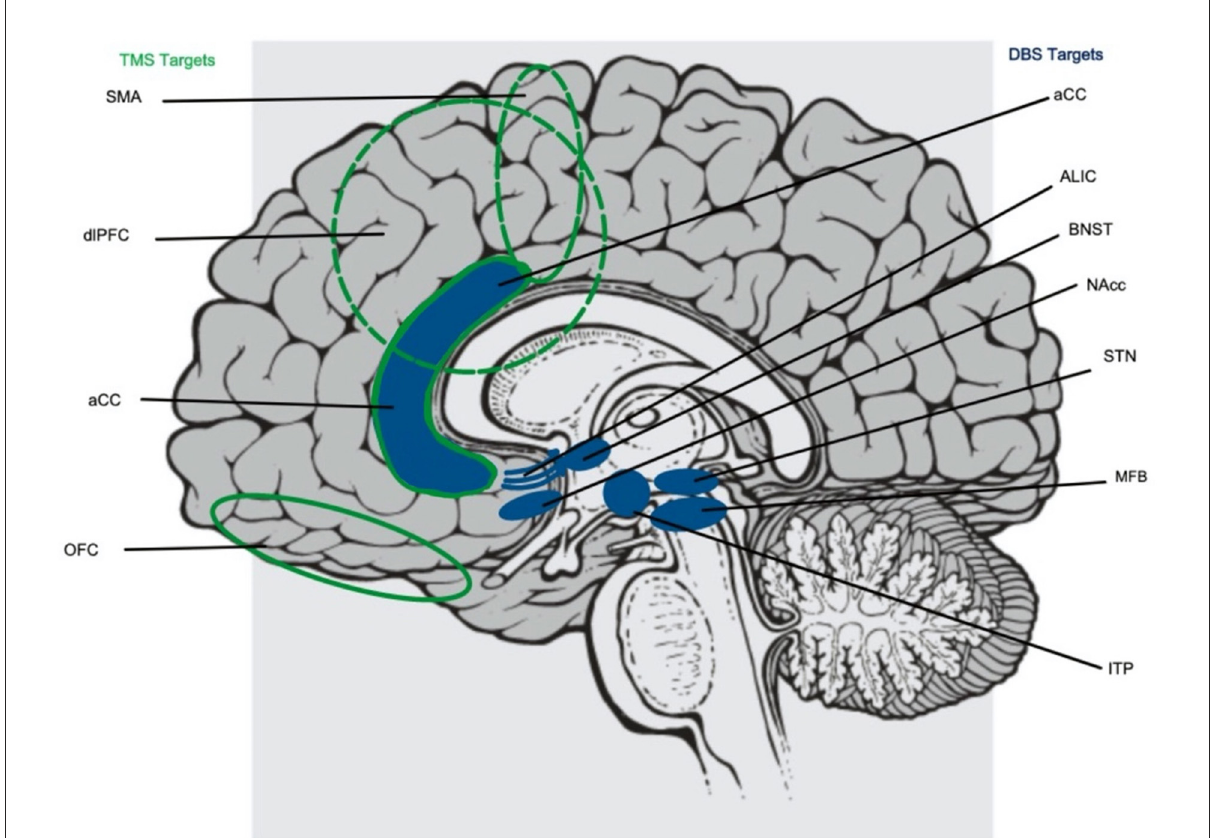
FIGURE2 Targets for both transcranial magnetic stimulation (TMS, highlighted in green to the left) and deep brain stimulation (DBS, highlighted in blue to the right) implicated in the treatment of obsessive compulsive disorder. TMS targets include the supplementary motor area (SMA), dorsolateral prefrontal cortex (dlPFC), and orbitofrontal cortex (OFC). DBS targets include the anterior limb of the internal capsule (ALIC), basal nucleus of the stria terminalis (BNST), nucleus accumbens (NAcc), subthalamic nucleus (STN), medial forebrain bundle (MFB), and inferior